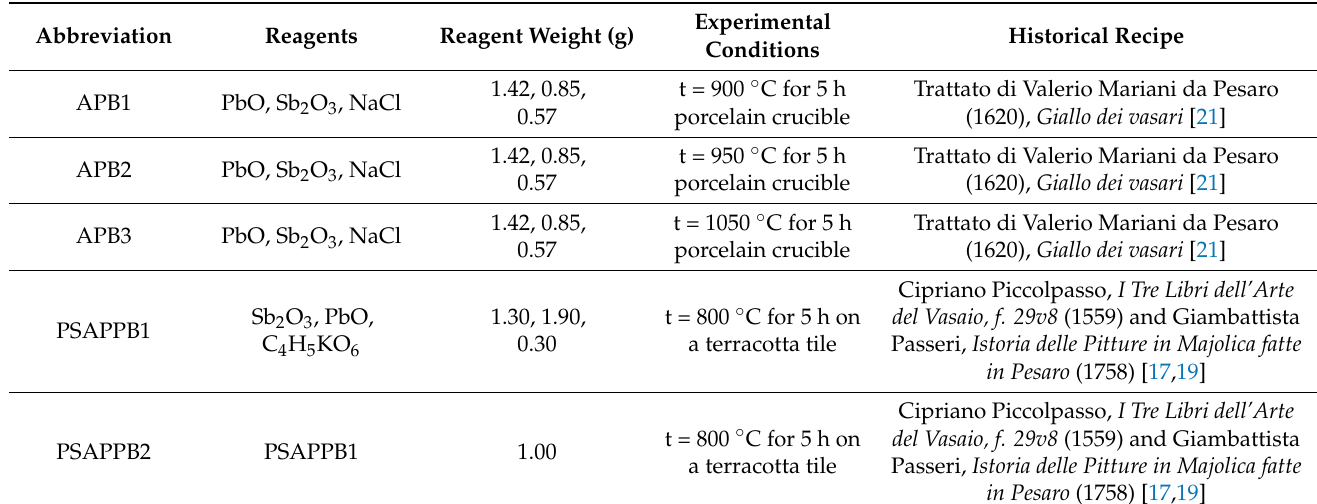
Table 1. List of pigments used for particle size and colour investigation and synthesis